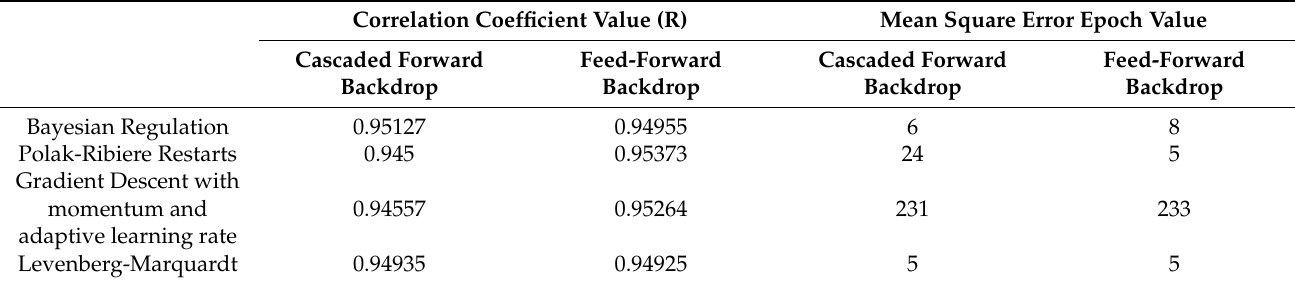
Table 2. Values of mean square errors and regression for the different algorithms.